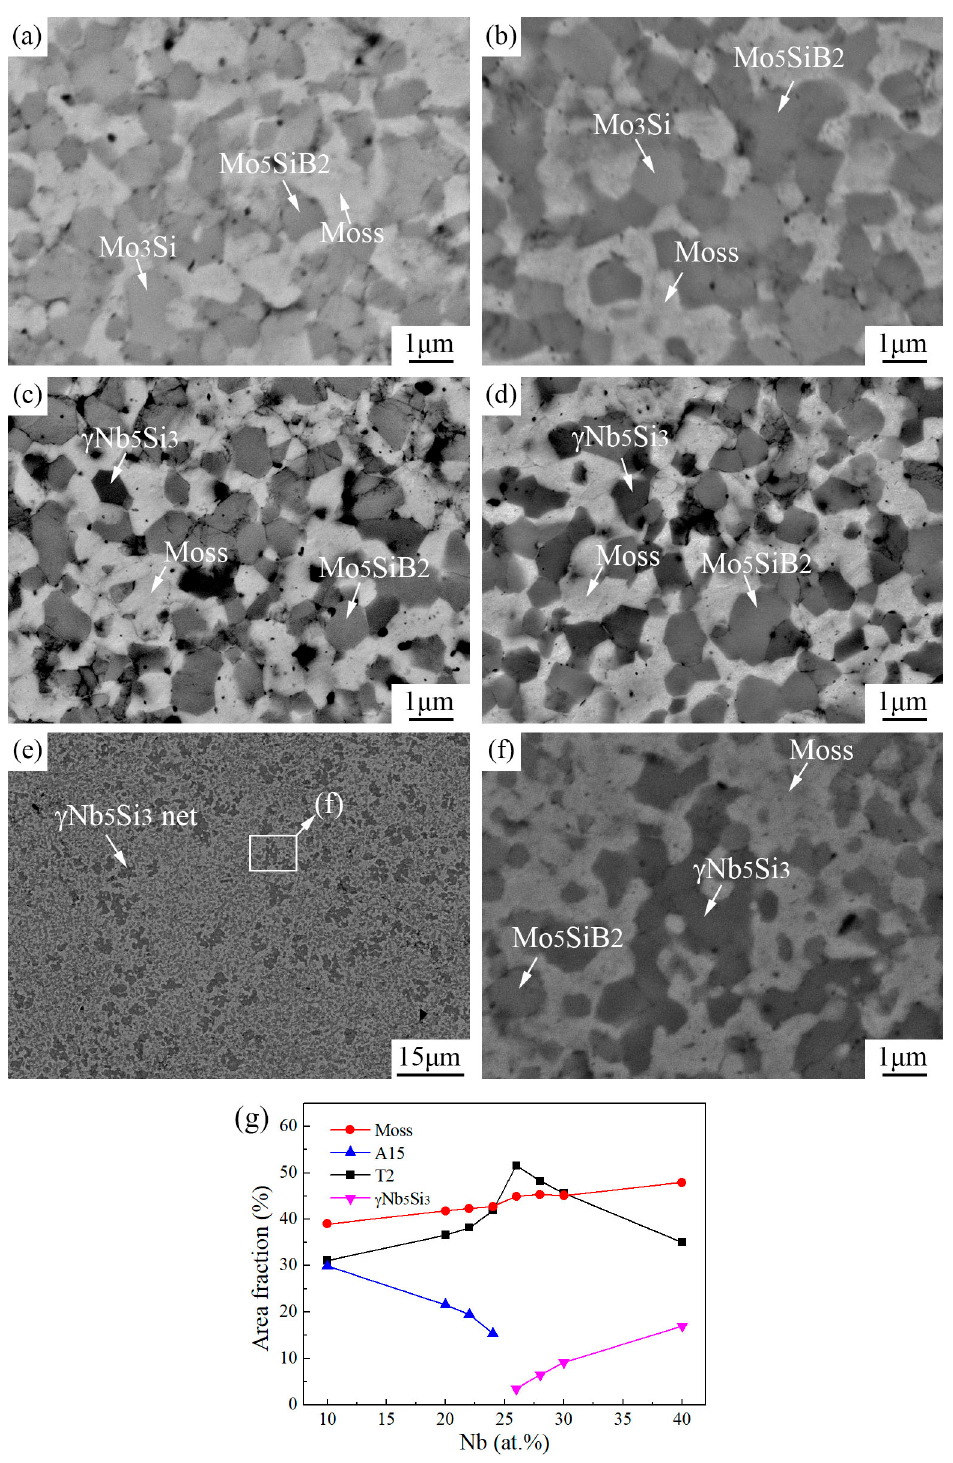
Figure 8. BSE images of the microstructure of the samples ( a )S-10Nb/30h, ( b )S-24Nb/30h, Figure8. BSEimagesofthemicrostructureofthesamples( a )S-10Nb / 30h, ( b )S-24Nb / 30h, ( c )S-26Nb / 30h, ( c )S-26Nb/30h, ( d )S-30Nb/30h, and ( e , f )S-40Nb/30h, and ( g )changes of area fraction of constituent ( d ) S-30Nb / 30h, and ( e , f ) S-40Nb / 30h, and ( g ) changes of area fraction of constituent phases vs. phases vs. Nb content. Nb